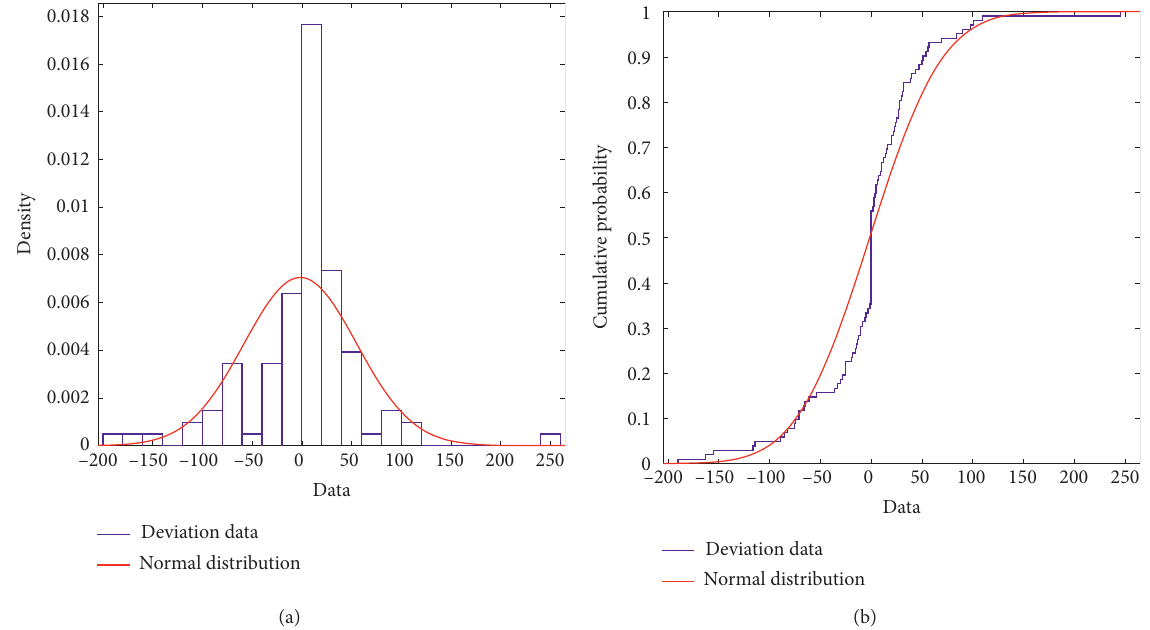
Figure 9: Time headway normal distribution: (a) density; (b) cumulative